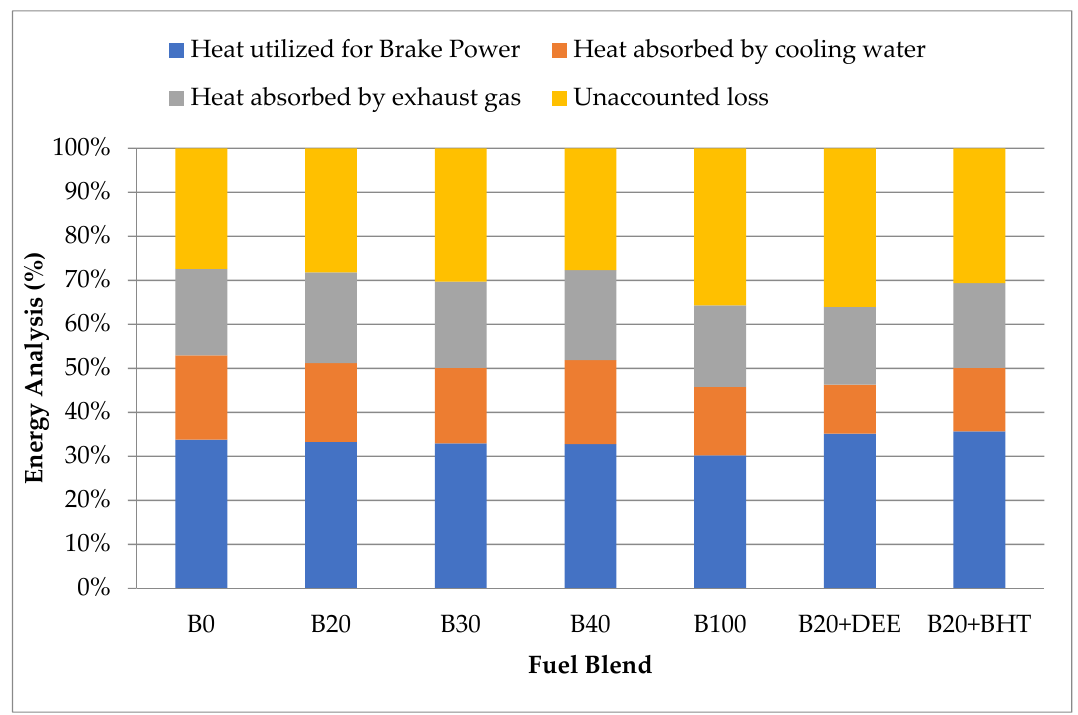
Figure 14. Energy analysis of all fuel blends at maximum engine loads.